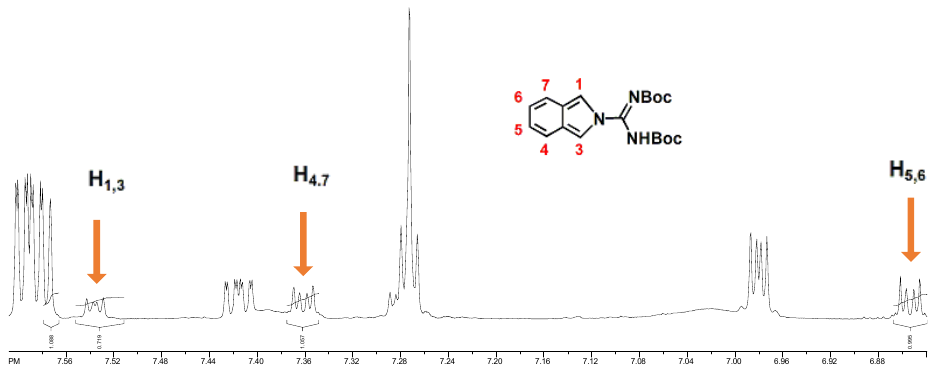
Figure 2. Section of 1 H NMR spectra (in CDCl 3 ) with assigned peaks of isoindole 2 .